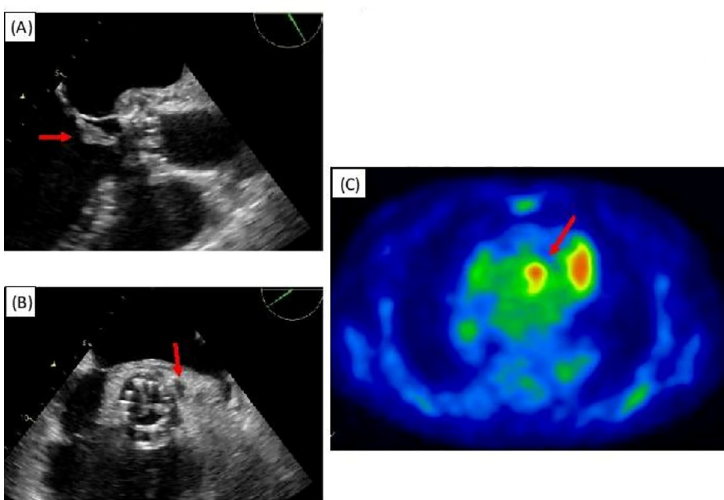
Fig 1. “Transcatheter heart valve (THV) endocarditis. A. Long-axis transesophageal view showing typical vegetation attached to the ventricular side of a THV (red arrow). B. Short-axis transesophageal view showing de novo peri- prosthetic echo-free cavities and thickened areas (red arrow). C. 4 fluoro-deoxyglucose positron emission tomography (FDG-PET) depicting cells with an enhanced glucose metabolism at the level of THV, thus corroborating the diagnosis of endocarditis” [29].